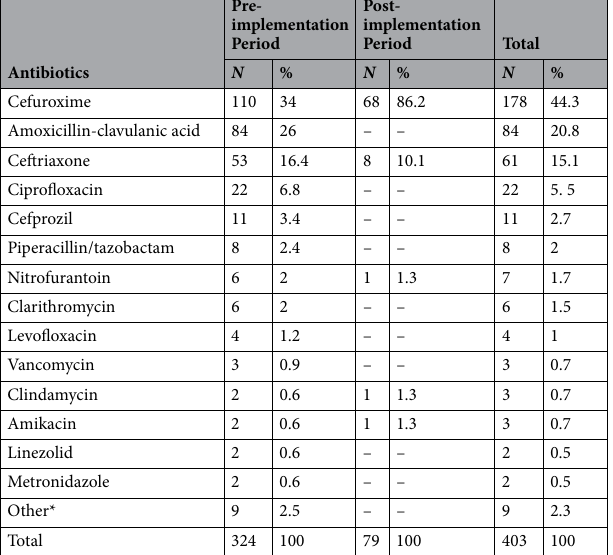
Table 4. Prophylactic antibiotics in surgical procedures. *Tigecycline, gentamicin, oloxacin, ceftazidime, moxifloxacin, azithromycin, cefixime and